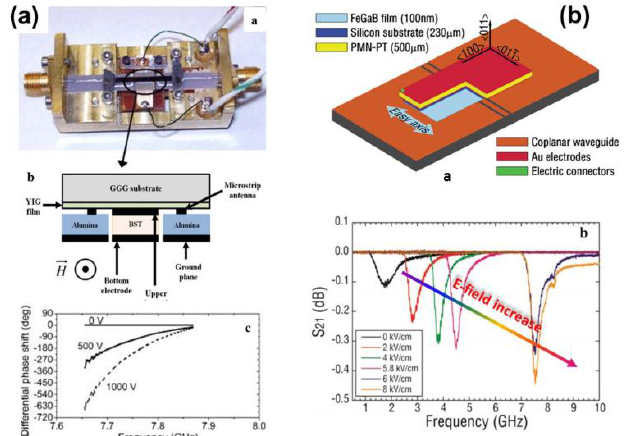
Figure 18. ( a ) Experimental prototype of the YIG/BST phase shifter, schematic of cross-section of the device and the YIG/BST layered structure, and electrically induced differential phase shift [122]. ( b ) Schematic of sample configuration and microwave measurement setup, and electric field dependence of the transmission coefficient (S 21 ) spectra of the FeGaB/PZN-PT resonator [132,133].